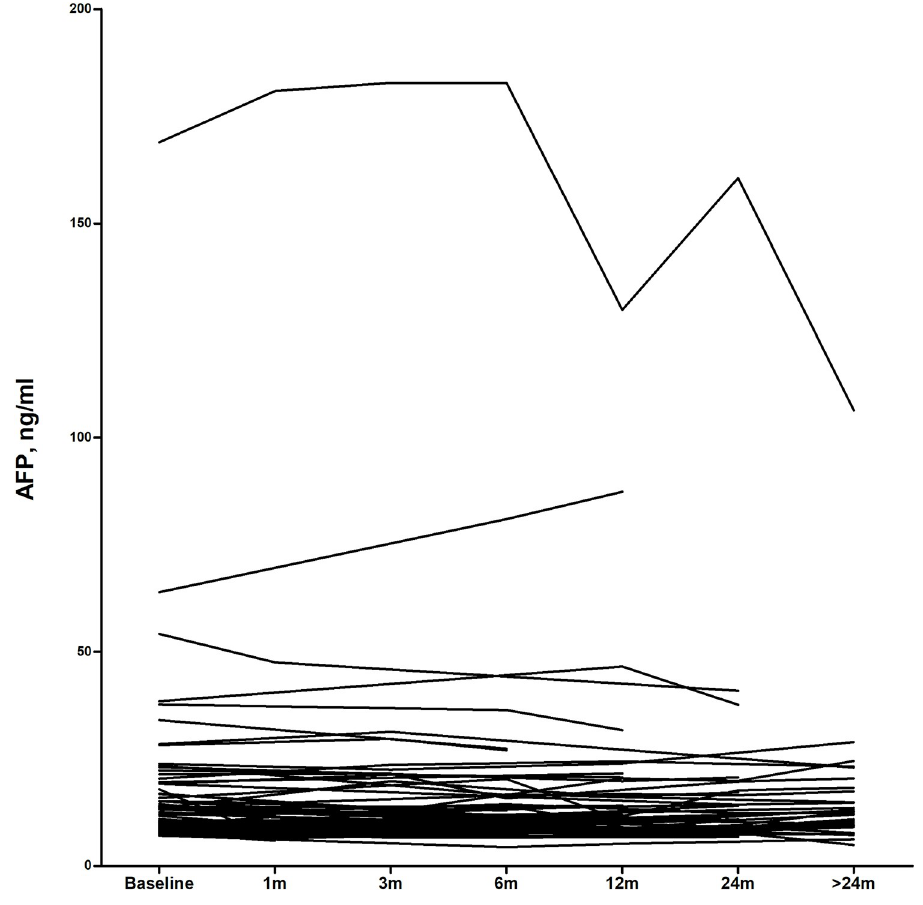
Fig 2. Longitudinal follow-up of AFP in the case group. The Median follow-up period was 12.9 months. No patients had newly developed malignancy or liver cirrhosis. AFP level stayed stable and there was no significant change over time among patients during